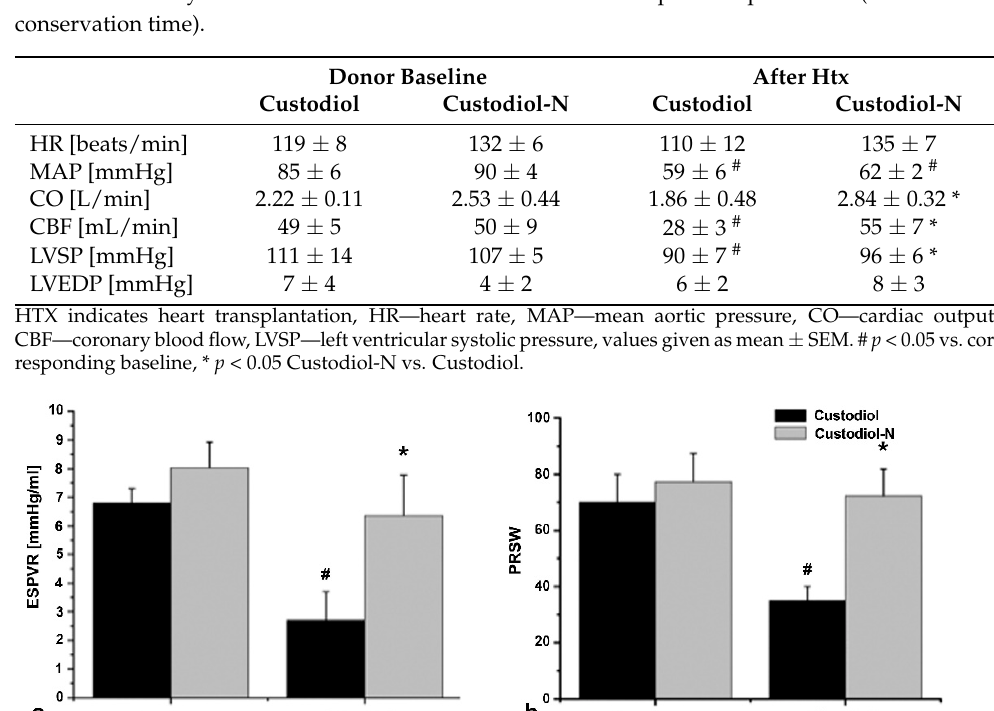
Table 3. High-energy phosphates (Series 1: 4 h conservation time).